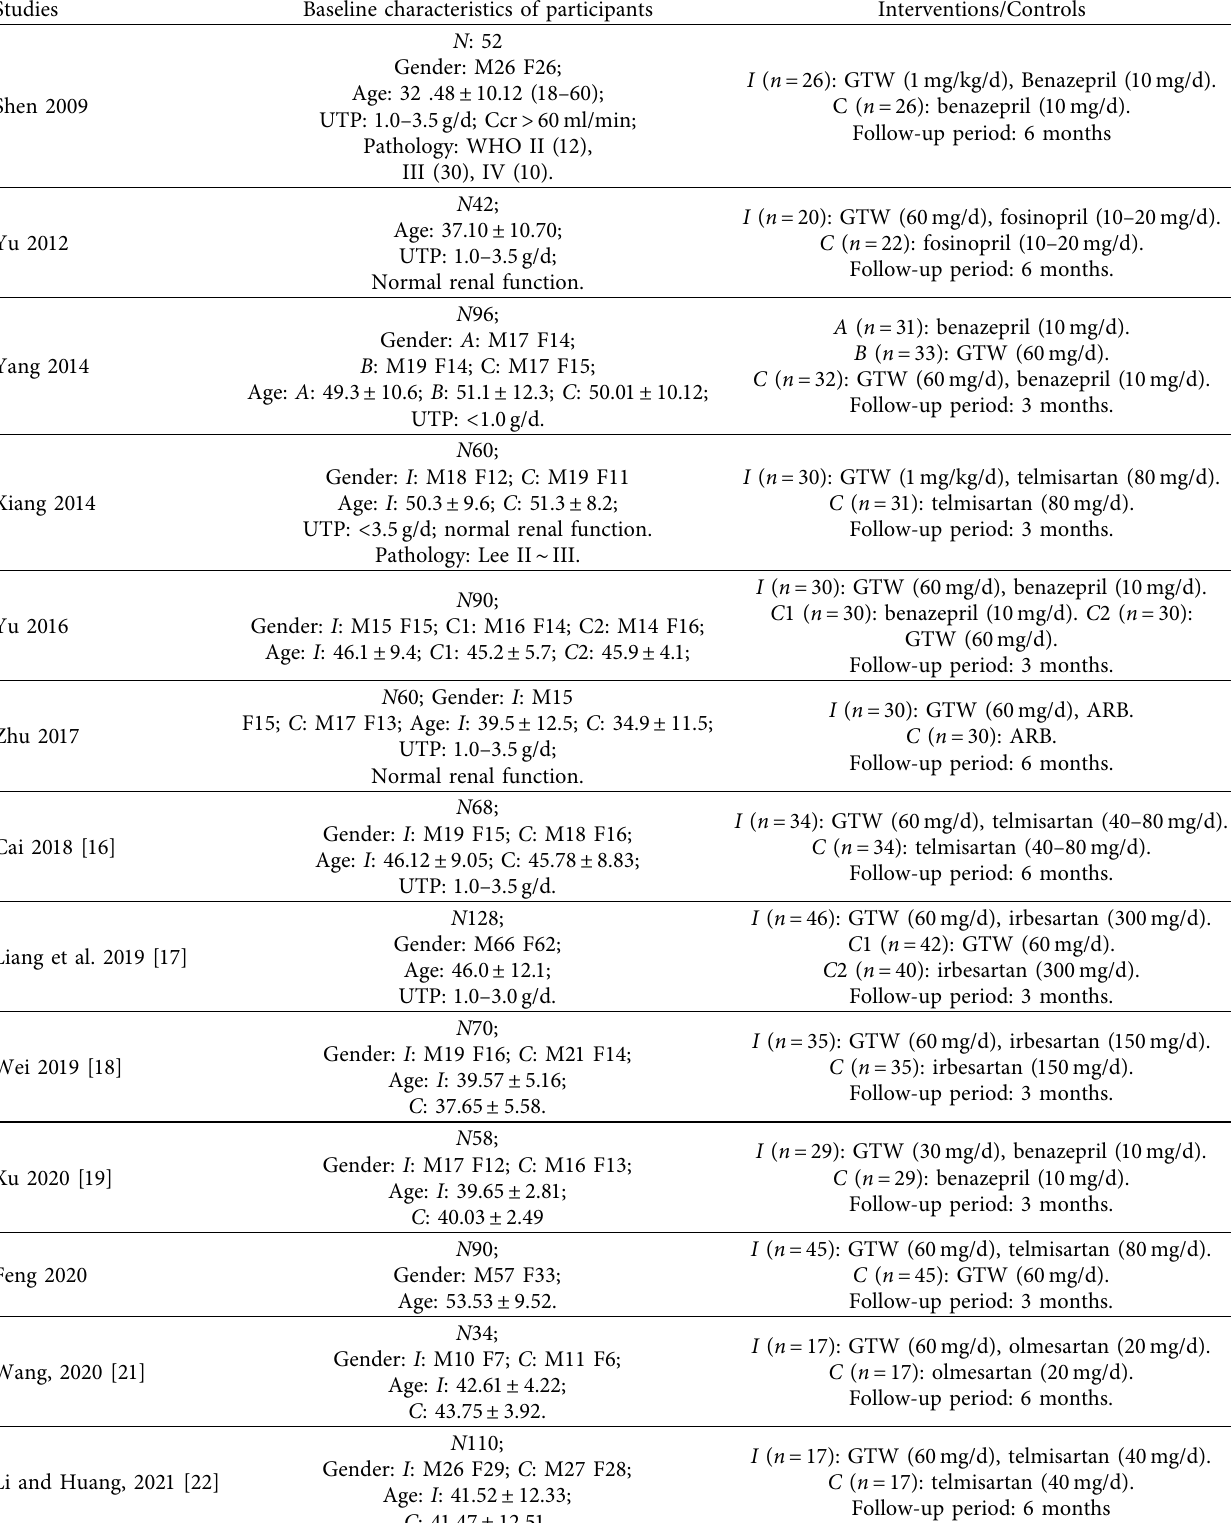
Table 1: Characteristics of the studies included in this systematic